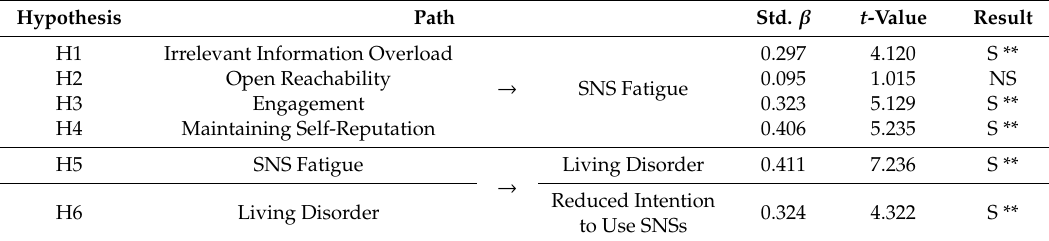
Table 8. Summary of hypothesis tests (H1 to H6).